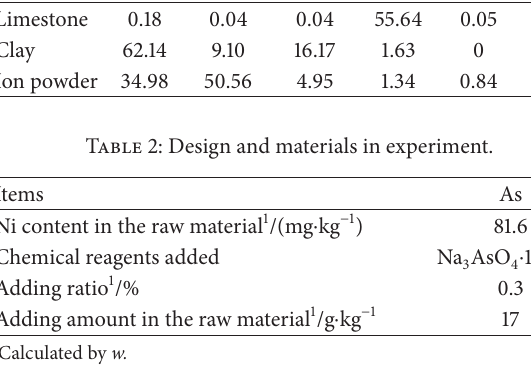
Table 1: Chemical composition of raw materials (%). Items